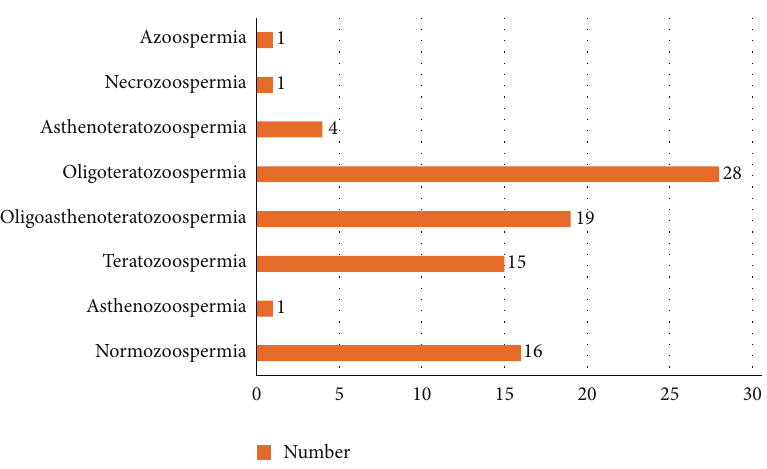
Figure 2: Interpretation of seminal parameters among study population. Table 3: Comparison of semen parameters among bacteriospermic and nonbacteriospermic samples.